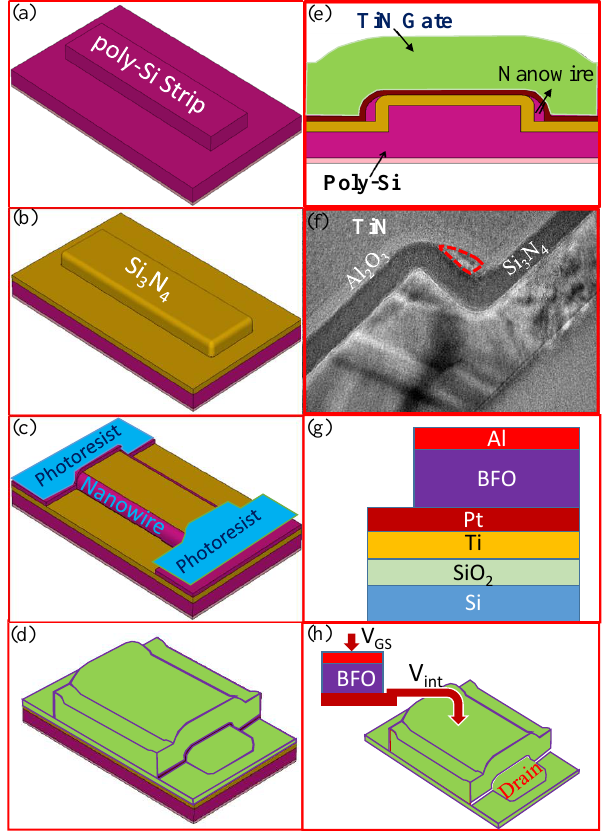
Figure 1. Key fabrication steps for the control TFT and BFO capacitor. ( a ) N + Poly-Si layer deposition and strip patterning, ( b ) Si 3 N 4 deposition, ( c ) N + Poly-Si layer deposition, N + Poly-Si NW channels and source/drain were Figure 2. ( d ) O 3 gate oxide and TiN deposition, then gate patterning, ( e ) the cross-sectional transistor with TiN gate, ( f ) the cross-sectional TEM image, where the red line indicates the Si channel. Its peripheries are 9.4 nm, 24 nm, and 35 nm, respectively. Due to 5-nm-thick Al 2 O 3 , the effective width (Weff)/channel of TiN gate is about 30nm in control TFT. ( g ) Schematic diagram of BFO capacitor. ( h ) A wire is connected to the BFO capacitor and a control transistor where it can be measured.